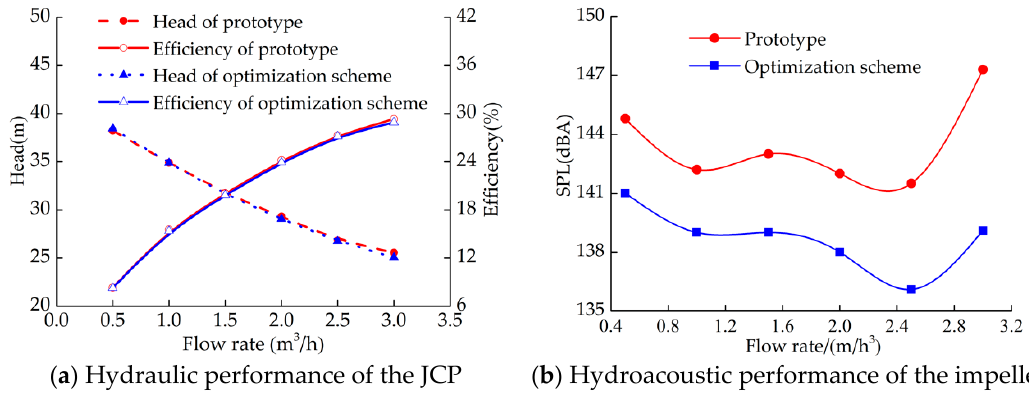
Figure 27. Performance comparison between the prototype and optimization scheme.